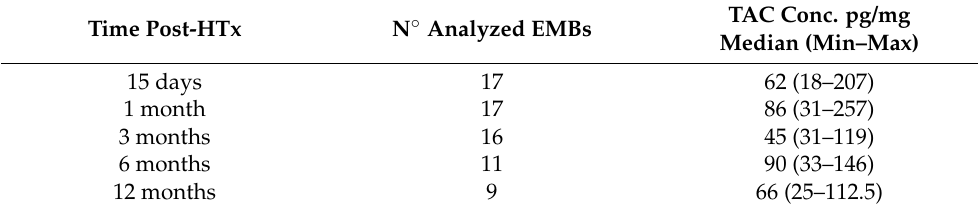
Table 1. TAC median concentrations in EMBs during the first year